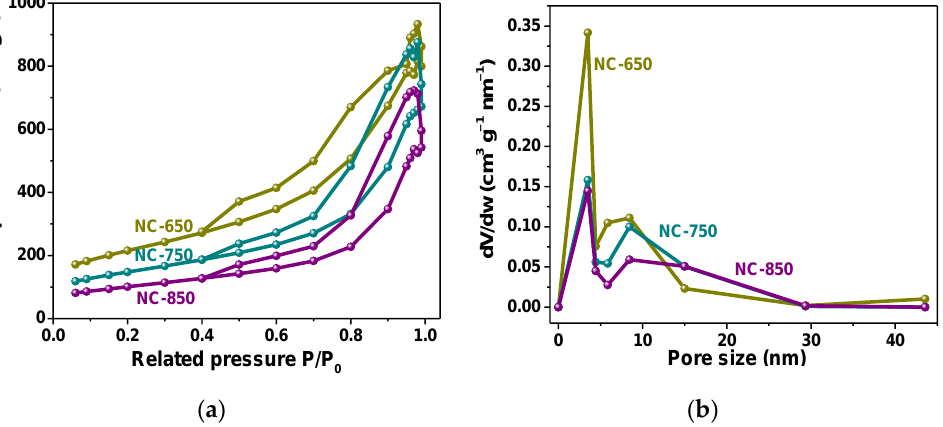
Figure 3. ( a ) Nitrogen adsorption – desorption isotherms at 77 K and ( b ) pore size distributions of NC-650, NC-750, and NC-850. Table 1. Temperature of the synthesis, specific surface area, pore volume, ratio of nitrogen forms, and LIB and SIB capacities of NC-650, NC-750, and